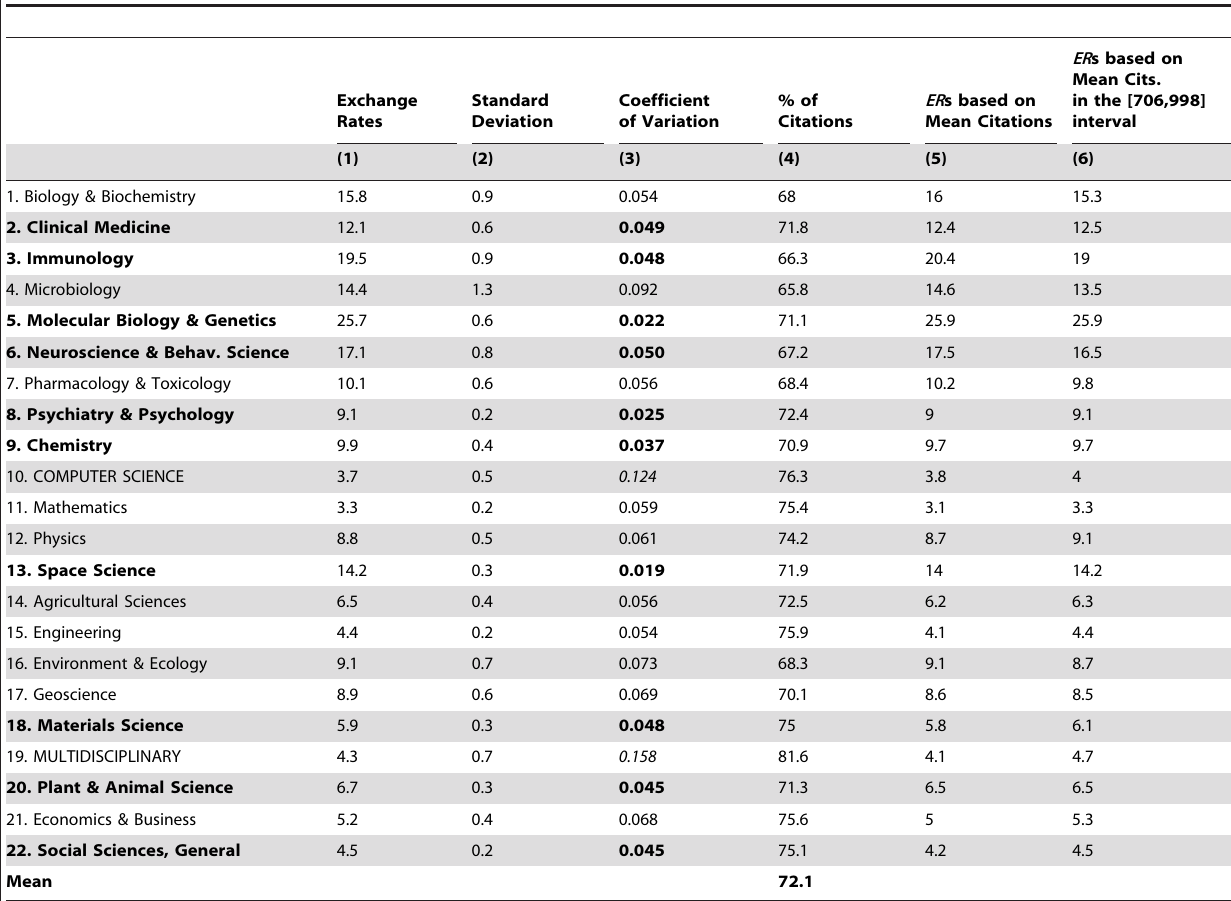
Table 1. Exchange Rates, Standard Deviations, and Coefficient of Variation for the ½ 706,998 (cid:2) Interval, and Exchange Rates Based on Mean